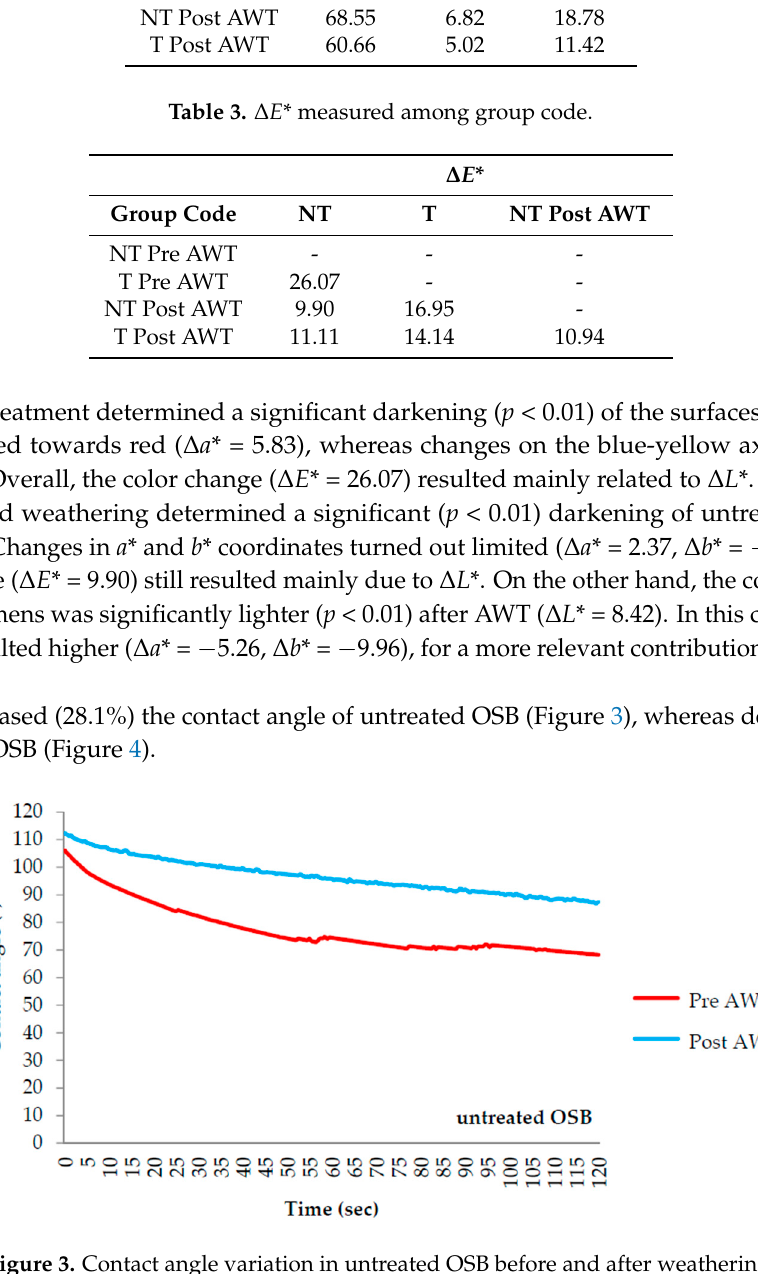
Figure 3. Contact angle variation in untreated OSB before and after weathering.